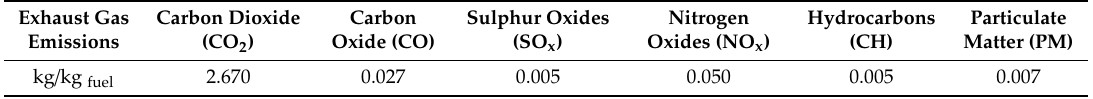
Table 4. Estimated values of diesel combustion product emissions.